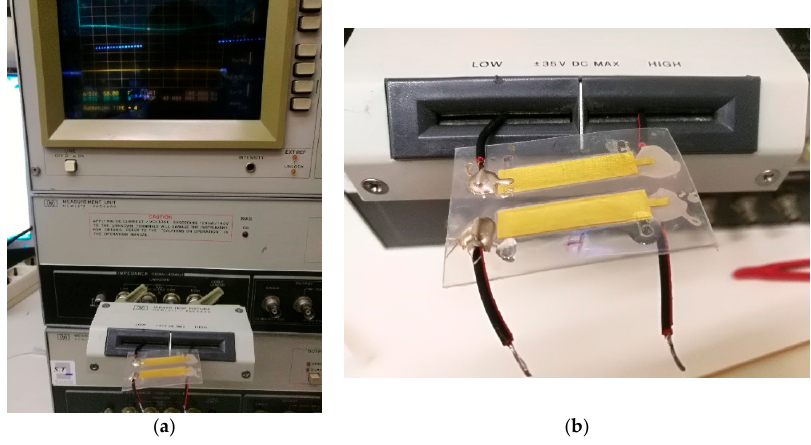
Figure 4. Experimental setup for the microfluidic-based platform ( a ) Impedance Analyzer HP4194A with the sample holder, ( b ) Developed microfluidics-based device under testing